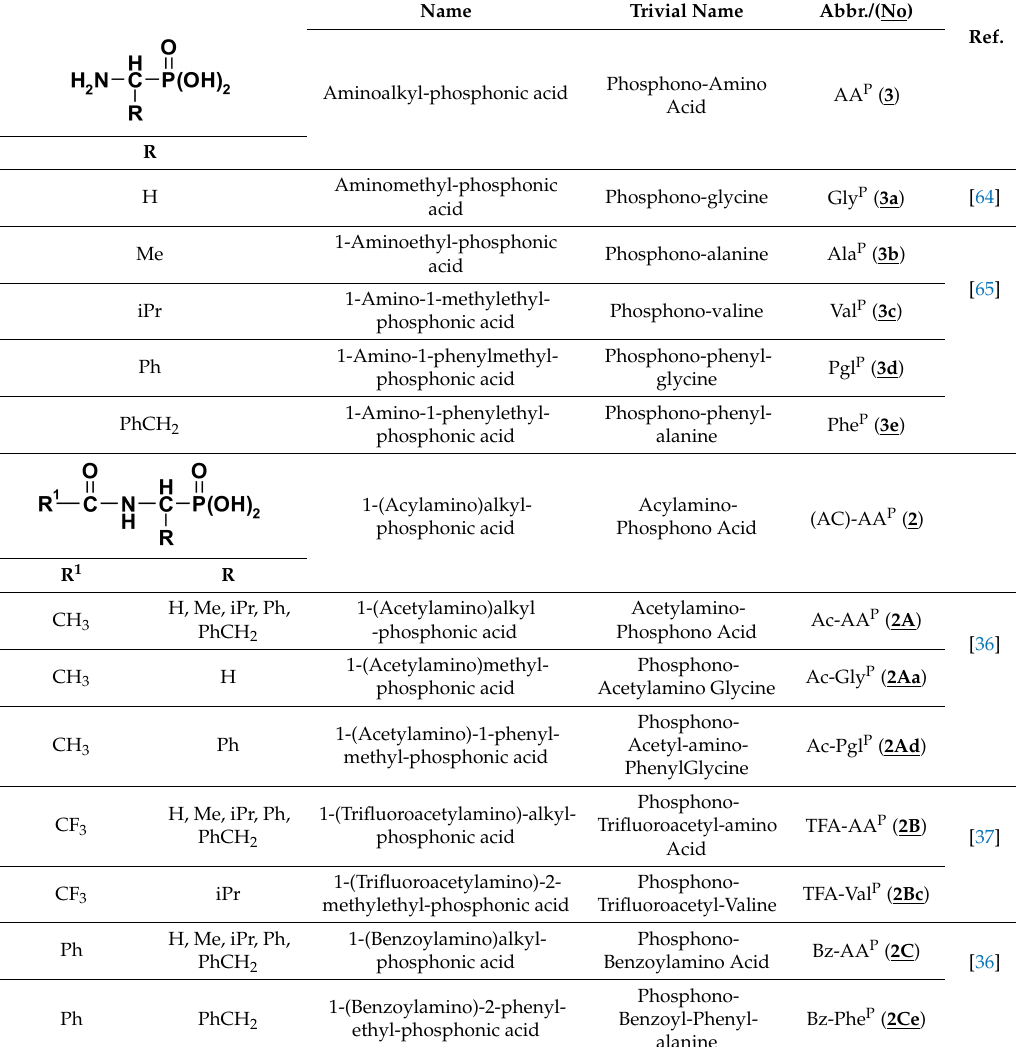
Table 10. Structures, names and abbreviations of aminophosphonic acids and corresponding 1-(acylamino)phosphonic acids discussed in this work a